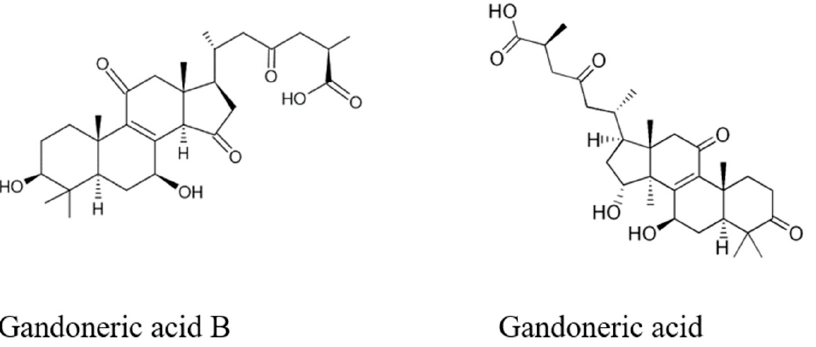
Figure 4. Selected chemical constituents of G. lucidum methanolic extract from the group of triterpe- noids.